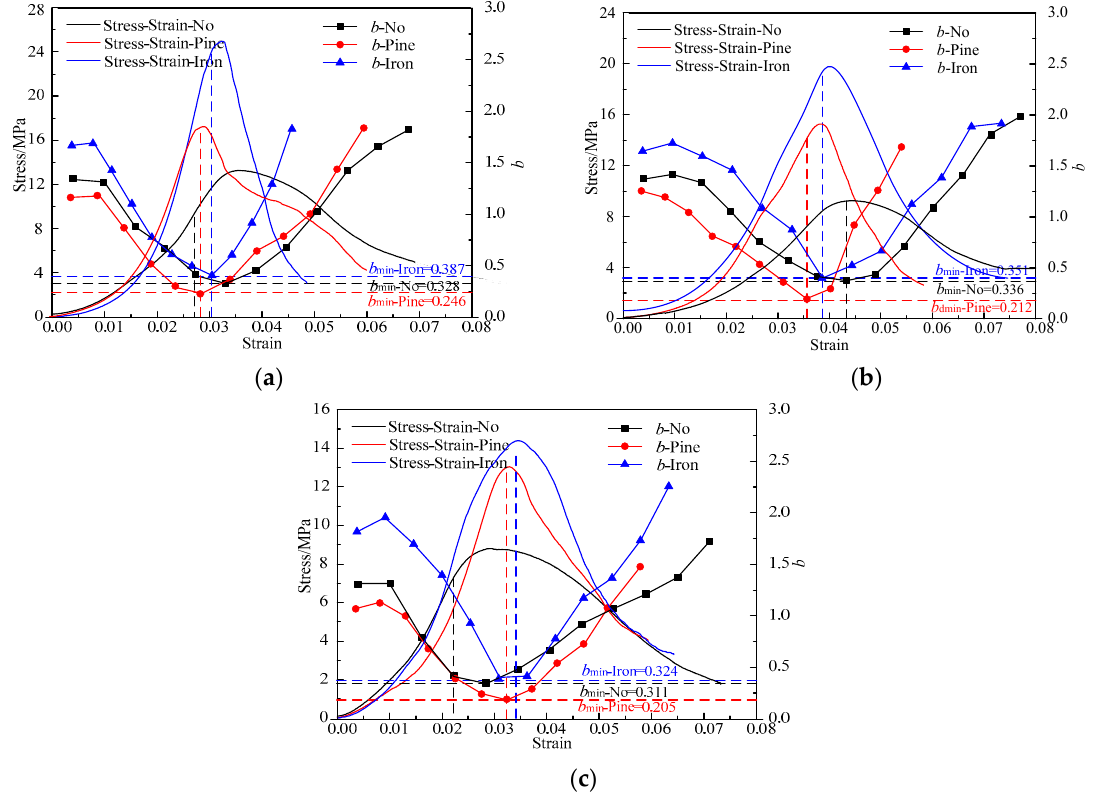
Figure 8. Stress–strain–b curves of mortar specimens with different cement–sand ratios: ( a ) cement–sand ratio 1:1, ( b ) cement–sand ratio 1:1.5, and ( c ) cement–sand ratio 1:2.